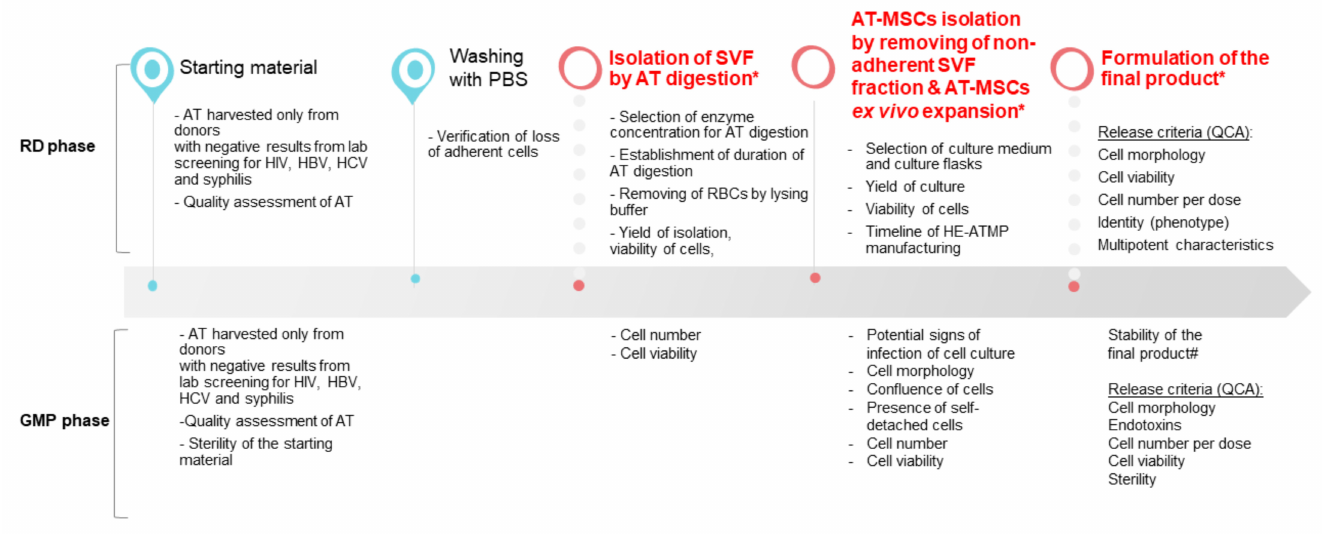
Figure 1. Overview of the HE-ATMP manufacturing process. In the diagram, we marked parameters that were assessed during the RD phase and the GMP phase (validation of the manufacturing process). (*) CPP: critical process parameters; (#) stability study was conducted during the validation of the manufacturing process; QCA: quality control